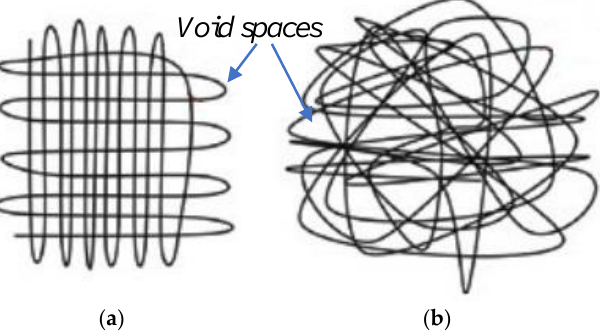
Figure 1. Schematic illustrations of ( a ) a woven and ( b ) a non-woven fiber mesh. Adapted with permission (CC BY 4.0) from [3] .